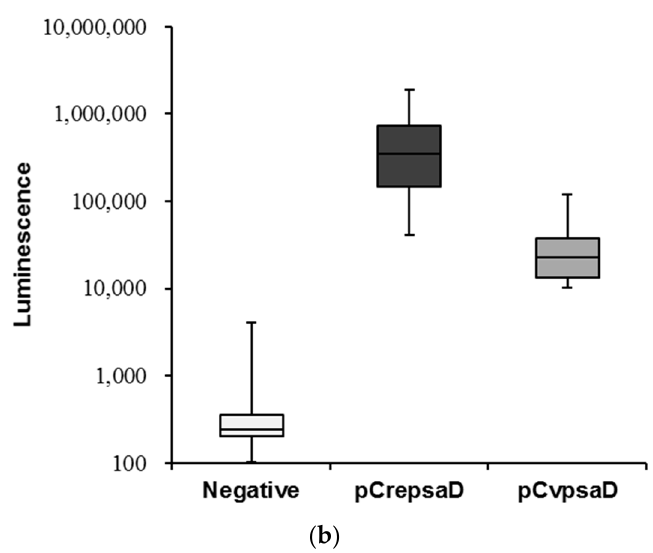
Figure 4. Determination of the strength of CvpsaD promoter. ( a ) Schematic representation of the promoter cassettes conjugated with Gaussia luciferase (GLuc) gene for strength analysis ( b ) Analysis of luciferase activity by the two promoters.